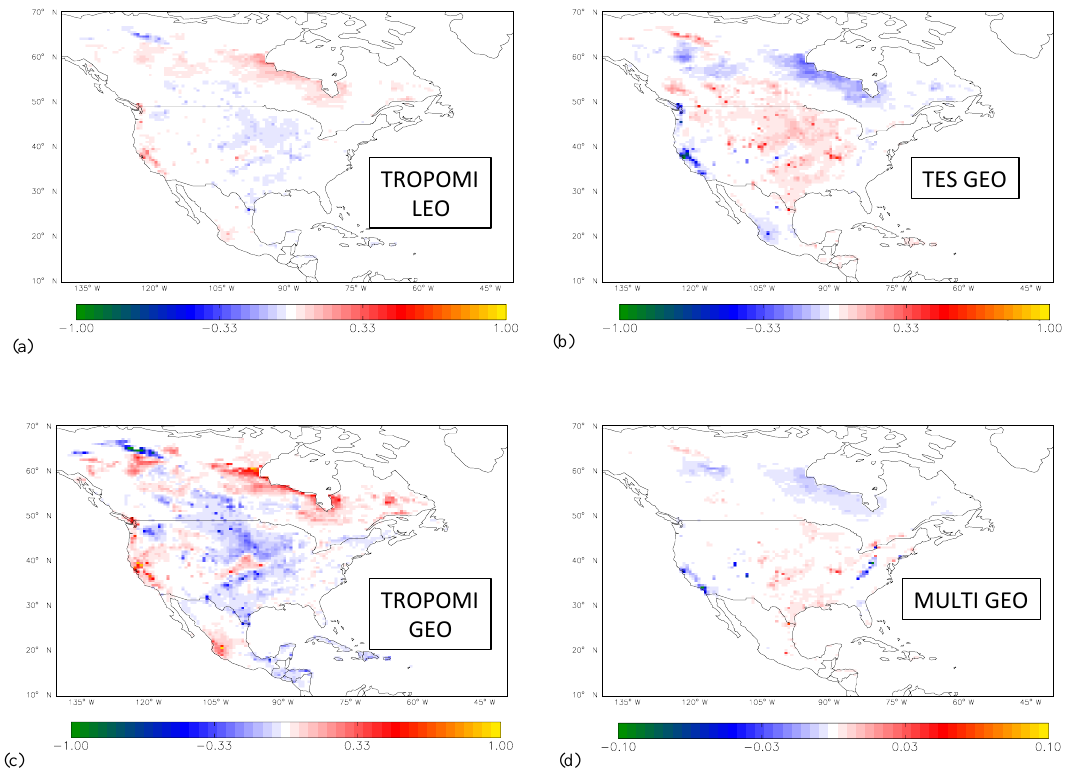
Figure 9. Sensitivity of the optimized emission scaling factors to uncertainties in boundary conditions for a 7-day inversion (1–8 July 2008), using (a) TROPOMI low-Earth orbit observations (TROPOMI_LEO); (b) GEO-CAPE observations with a TES-like instrument